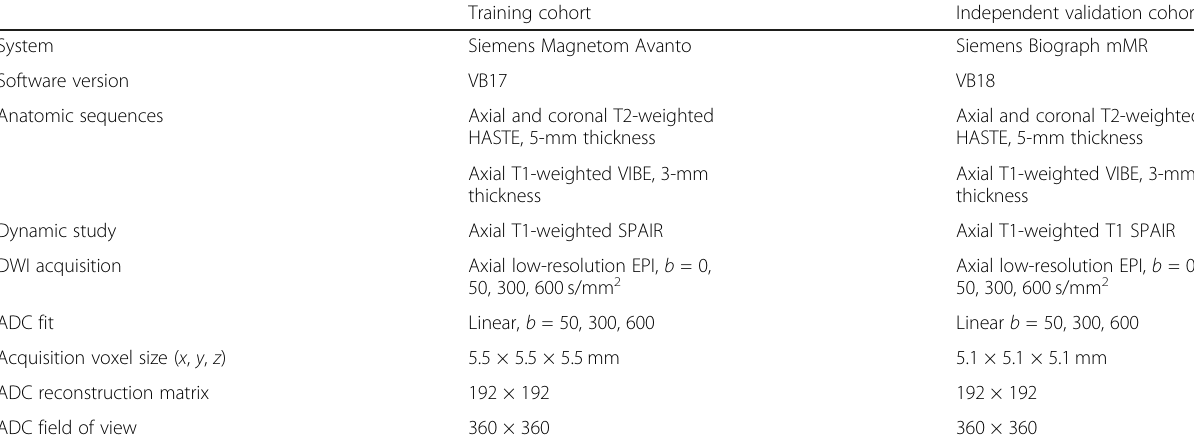
Table 1 Acquisition parameters for the training and independent validation cohorts